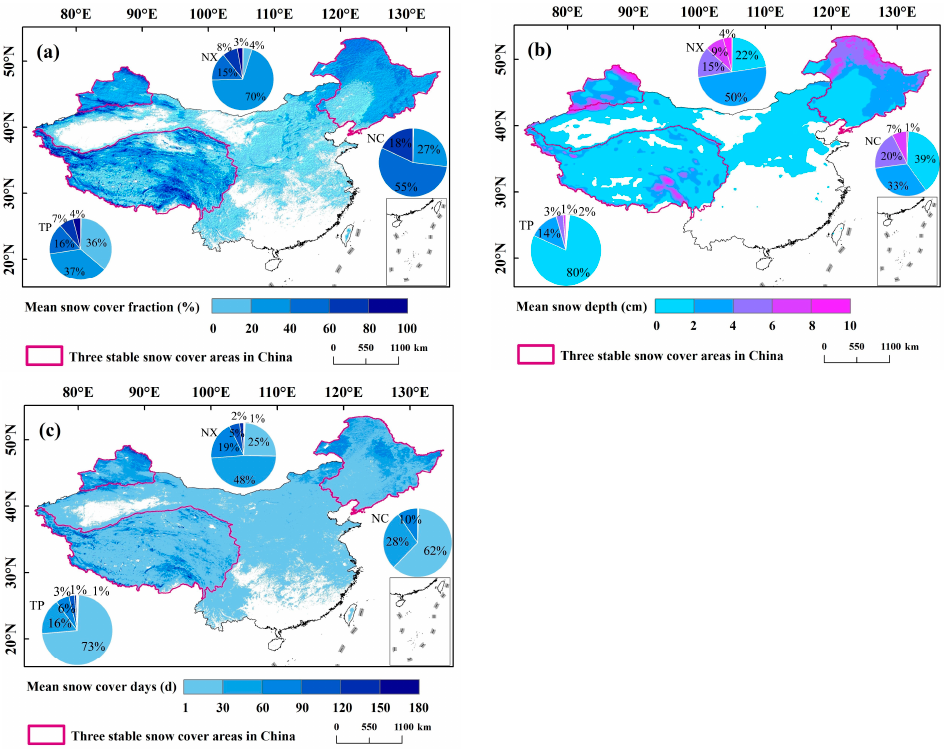
Figure 5. Spatial distribution of average annual SCF ( a ), SD ( b ), and SCDs ( c ) in the TP, NX, and NC from 2001 to 2019 or 2020. The pie chart represents the percentage of the total number of different intervals, and the color corresponds to the color of the legend.